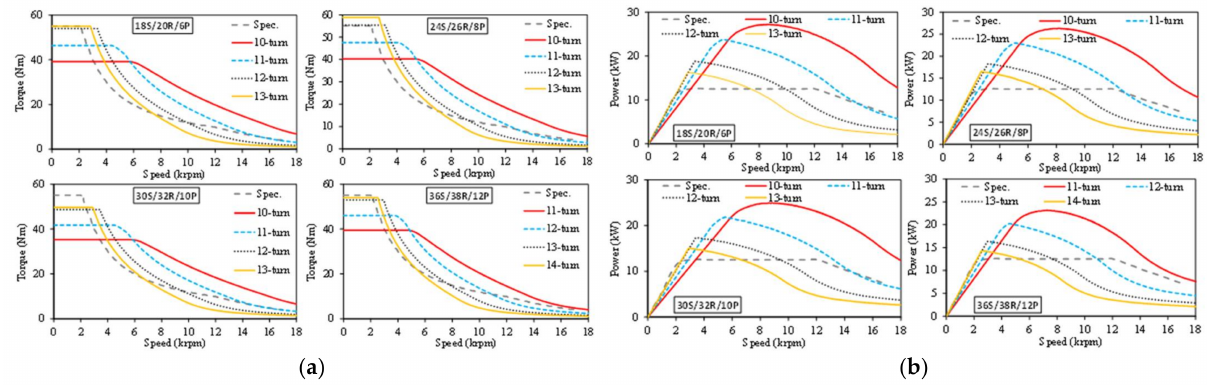
Figure 33. Flux-weakening characteristics of 70 mm AIMs with different S/P combinations and number of turns: ( a ) torque-speed and ( b ) power-speed.